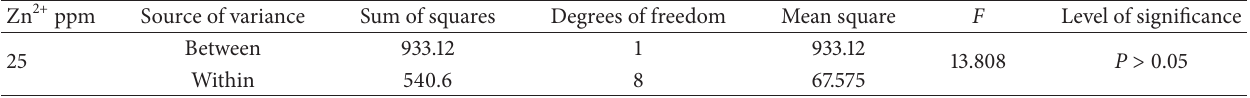
Table 4: Distribution of 𝐹 -value between inhibition efficiencies of various concentrations of L-Arginine Zn 2+ . Zn 2+ ppm Source of variance